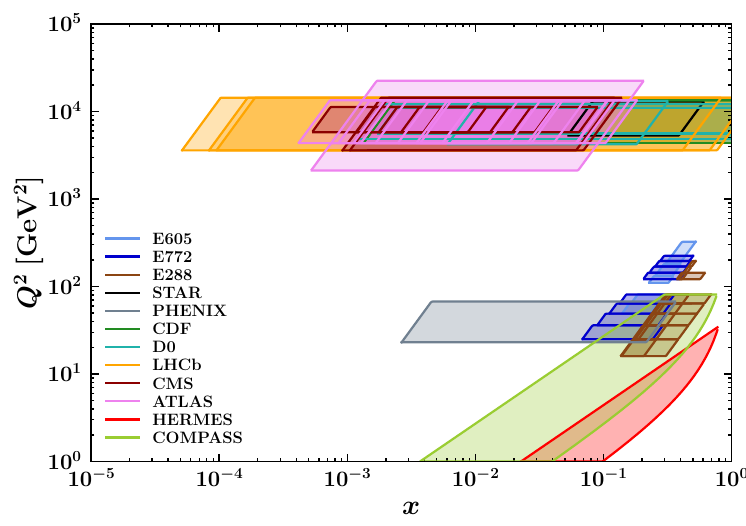
Figure 3 . The x vs. Q 2 coverage spanned by the experimental data considered in this analysis (see also table 2 and table